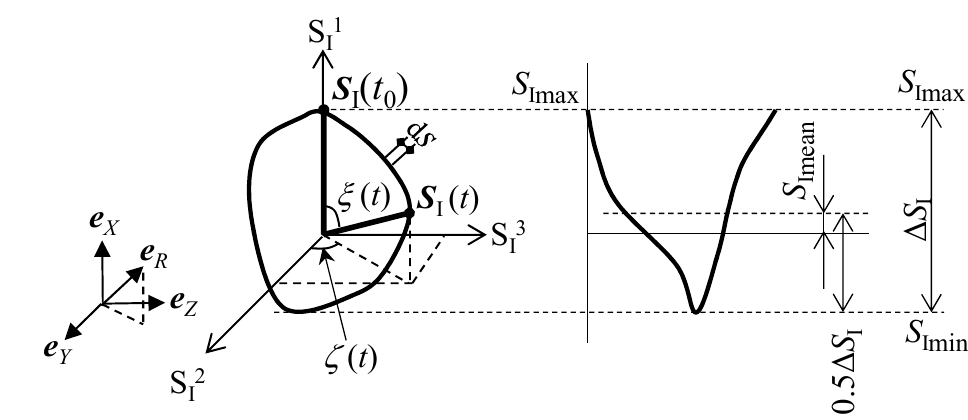
Figure 3: Definition of principal range and mean principal